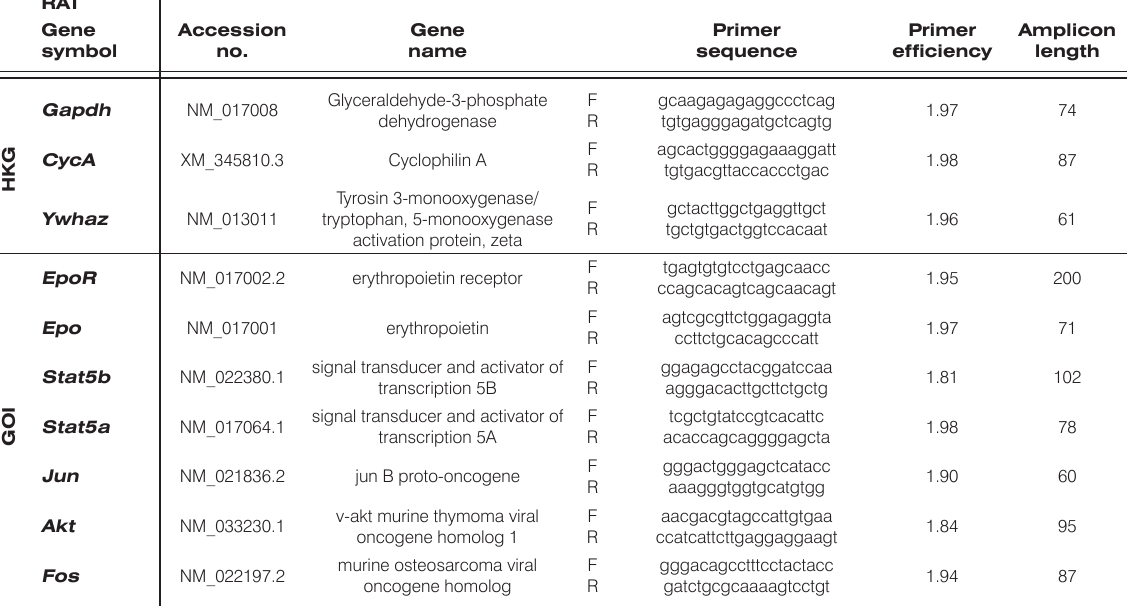
were (re)evaluated with qPCR on 35 SH-SY5Y samples (Table 1). In PC12, the expression of three most common used reference genes according to the literature ( Gapdh , CycA and Ywhaz ) [20,31,32] and seven GOI involved in Epo signal transduction (Table 3) were evaluated with qPCR on 41 samples (Table 1). Low variability of quantification cycle (Cq) of tested GOI on each cell line